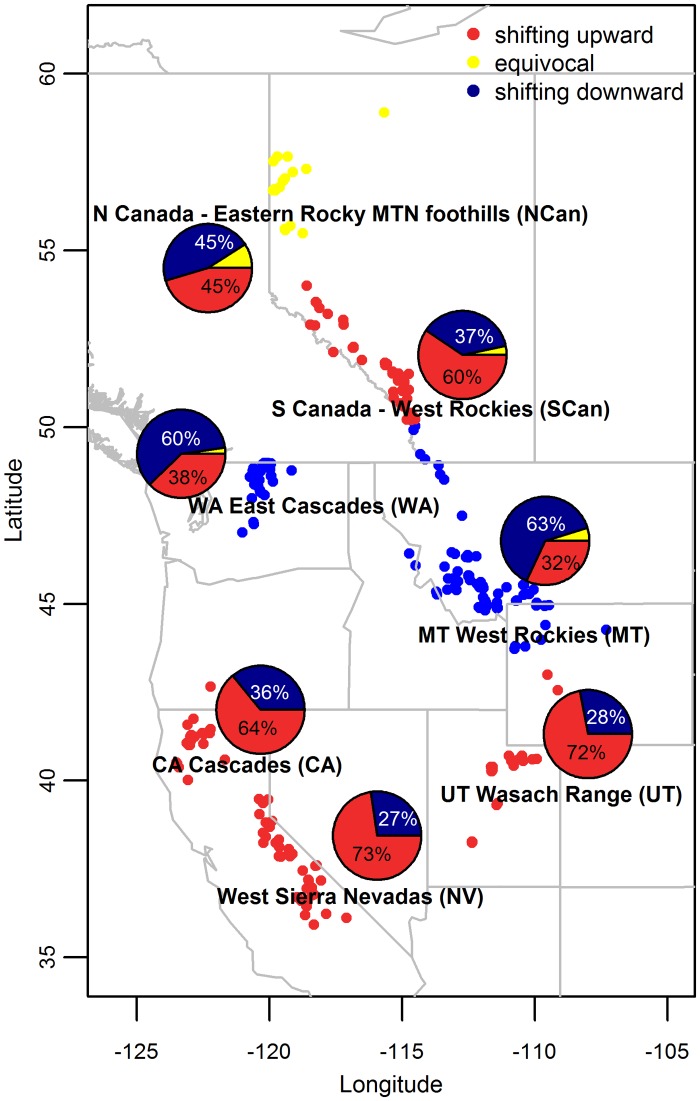
Species distribution shifts were calculated within each of the seven topographically distinct regions within western North America.Each circle represents the geographic coordinate of the highest elevation of occurrence for each species within a region. All circles within regions are colored according to whether most species (Binomial test, p<0.05, see Table 1) in that region shifted upward (red), downward (blue), or if the direction of change was equivocal (Binomial test, p > 0.05) (yellow). Pie charts indicate the percentage of species shifting in each direction within each region (see Table 1).